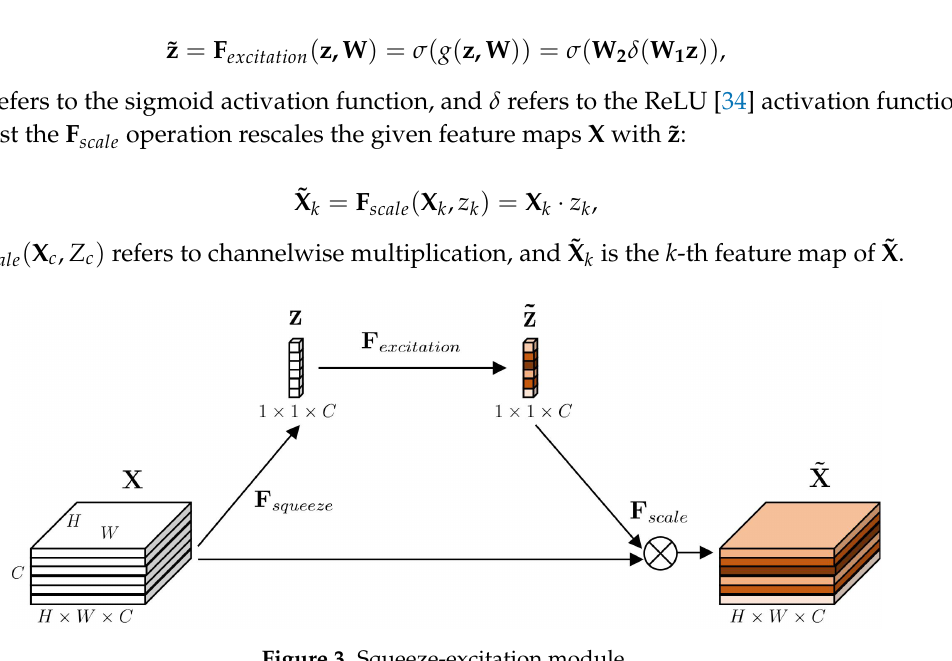
Figure 3. Squeeze-excitation